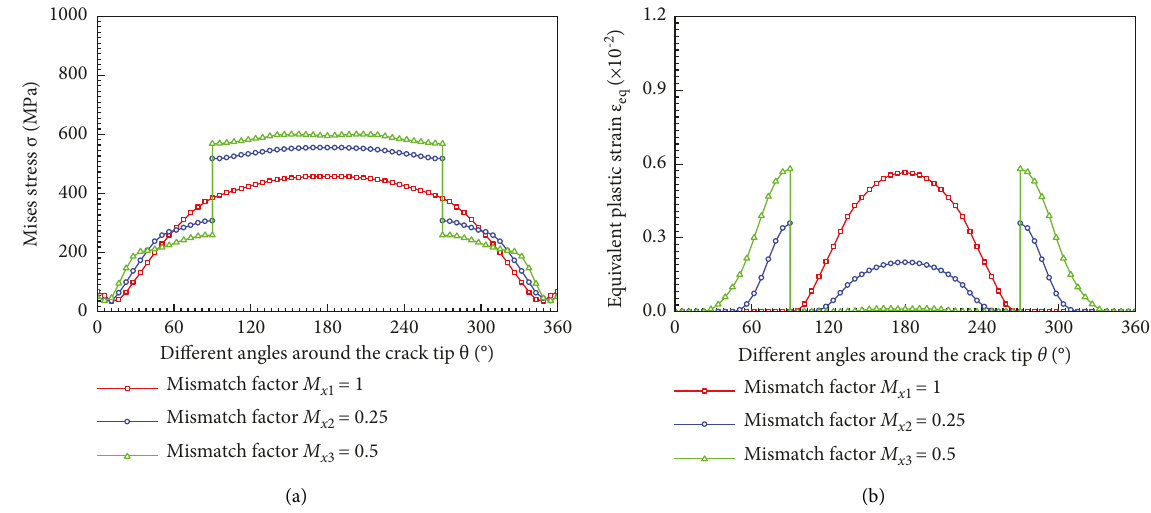
Figure 13: Curve of the sandwich structure welded joint model whose yield strength changes in the x -direction. (a) Von Mises stress curve at crack tip. (b) Equivalent plastic strain curve at crack